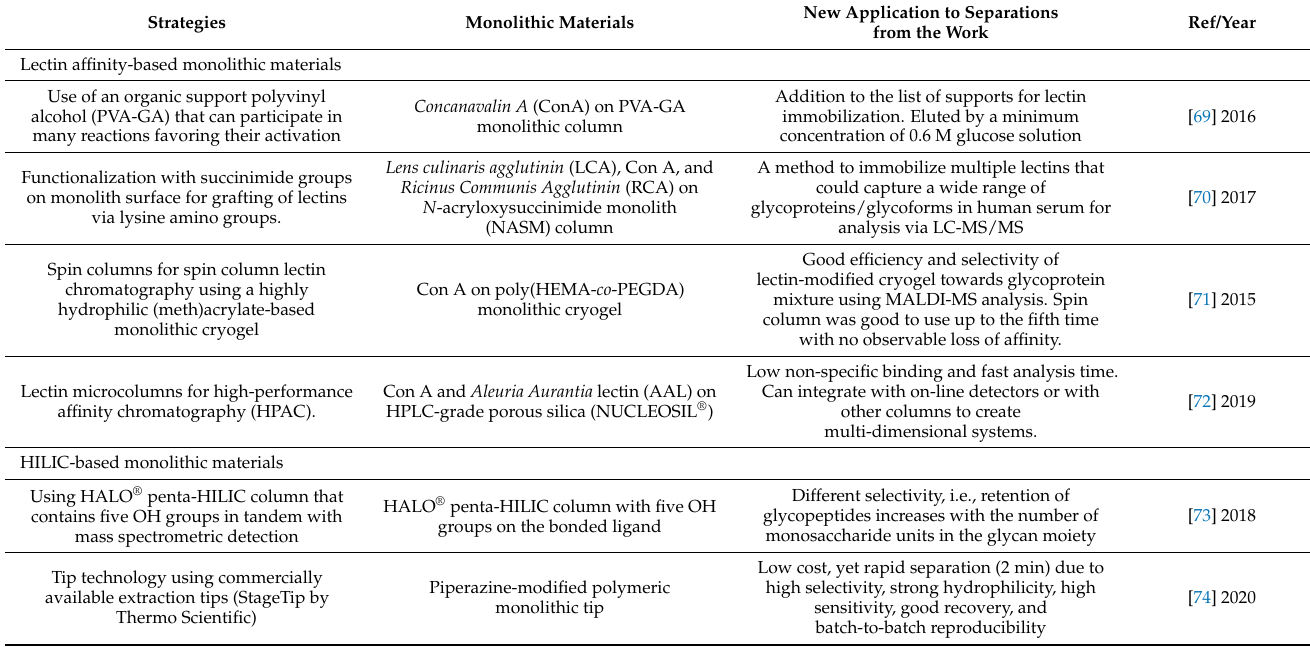
Table 1. Recent strategies in preparation of monolithic materials for the separation of